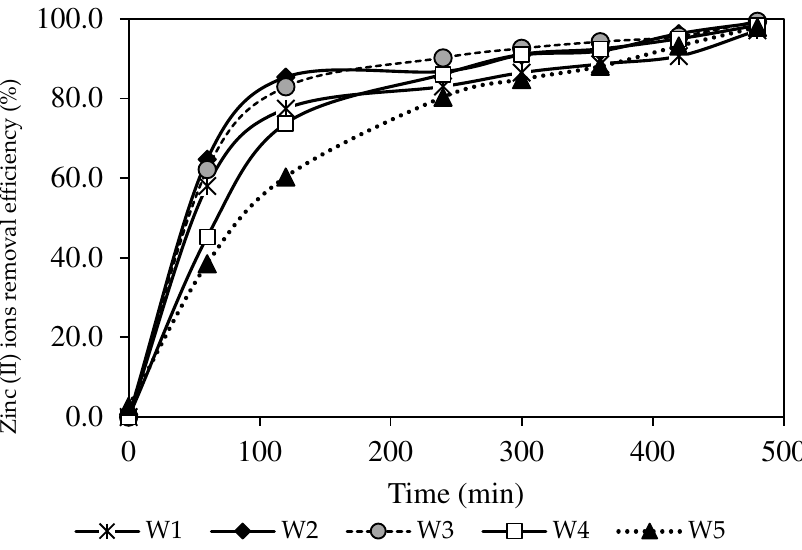
Figure 9. The Zn 2+ removal efficiency percentages of the PIM and MM-PIM samples. The W4 and W5 membranes with MWCNT loads of over 1.0% demonstrated a lower diffusion rate than the W1, W2, and W3 membranes before four hours. The increased concentration of nanoparticle inclusion linearly increased the membrane density, leading to a lower [ZnR2.HR](org) complex in the membrane [67]. Furthermore, water uptake characterisation in Table 4 describes the MWCNT content above 1.0% as hydrophobic, since the bonding region between metal ions and the membrane surface is smaller. Accordingly, the removal of Zn 2+ was favourable through the W1, W2, and W3 membranes. The concentration of Zn 2+ collected in the receiving phase is displayed in Figure 10. The line plot in Figure 10 exhibits an ascending trend of the Zn 2+ concentration in the receiving phase, demonstrating that extraction and back-extraction processes occurred the highest Zn 2+ concentration, close to 10 mg/L, whereas the W1 membrane possessed the lowest concentration of Zn 2+ at 7.03 mg/L. The data implied that the back-extraction process was less effective for the PIMs without nanoparticles. 0.02.04.06.08.010.012.0